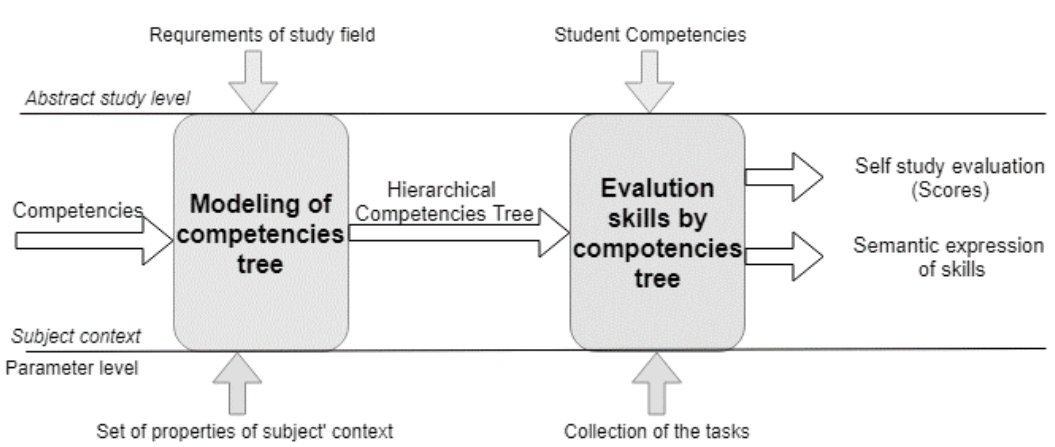
Figure 3. An abstracted view of competency tree design and application system.